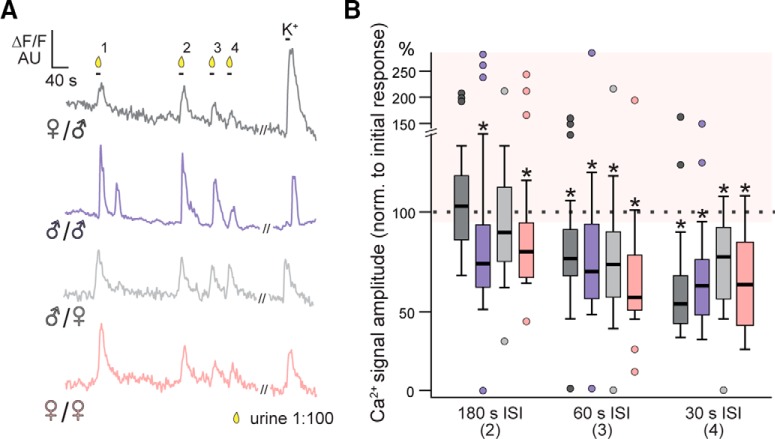
Susceptibility to sensory adaptation is a sex-specific function of the stimulus-recipient combination. A, Representative original recordings of cytosolic Ca2+ signals from individual VSN somata in Cal-520/AM-loaded acute VNO slices. The integrated relative fluorescence intensities (ΔF/F) in user-defined ROIs are displayed in arbitrary units and viewed as a function of time. Ca2+ transients are evoked by diluted urine (1:100; 10 s) and elevated extracellular potassium (K+; 50 mM; 10 s). Temporal stimulation paradigm as in Figure 1. Trace colors indicate specific stimulus-recipient combinations: male VNO/female urine (dark gray), male VNO/male urine (purple), female VNO/male urine (light gray), female VNO/female urine (light red). B, Box plots of Ca2+ signal amplitudes (normalized to the initial response) evoked by the 2nd, 3rd, and 4th exposure to urine. Colors denote stimulus-recipient combination as in A: male VNO/female urine (dark gray; n = 60), male VNO/male urine (purple; n = 46), female VNO/male urine (light gray, n = 42), female VNO/female urine (light red, n = 79). Note that more pronounced sensory adaptation is apparently evoked by same sex (male-male; female-female) stimulation. Asterisks (*) indicate statistical significance, p < 0.05 (Dunnett test).